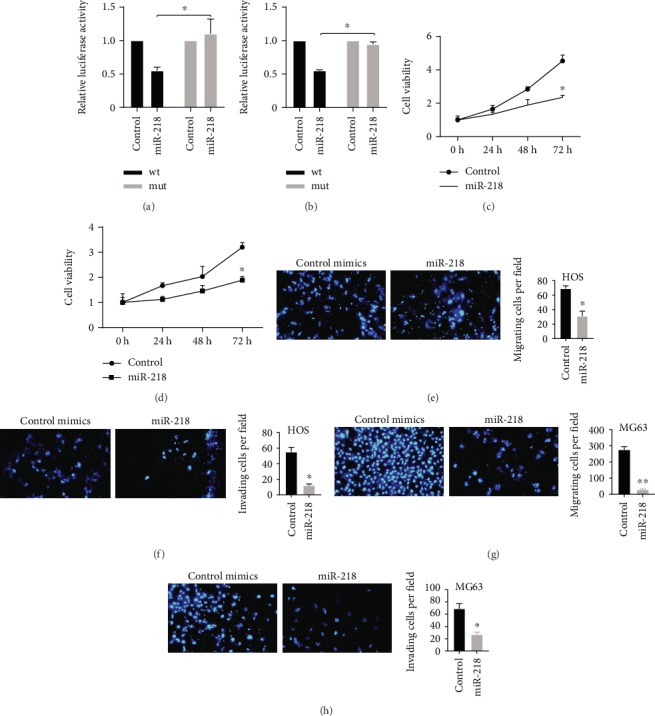
CircEIF4G2 sponges miR-218. (a and b) Dual-luciferase reporter assays showed that miR-218 decreases the relative luciferase activity of the wild-type circEIF4G2 luciferase plasmid compared with the mutant in both HOS (a) and MG63 (b) cells. (c and d) Overexpression of miR-218 significantly suppressed HOS (c) and MG63 (d) cell proliferation using the CCK-8 assay. (e and f) Overexpression of miR-218 significantly suppressed HOS cell migration (e) and invasion (f) using the Transwell assay. (g and h) Overexpression of miR-218 significantly suppressed MG63 cell migration (g) and invasion (h) using the Transwell assay.